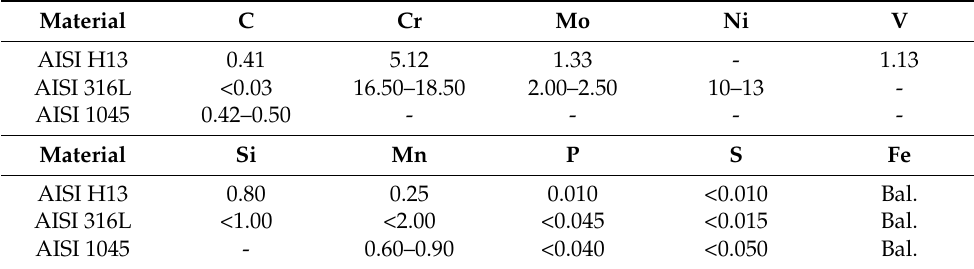
Table 1. Chemical composition of the employed materials (wt.%).